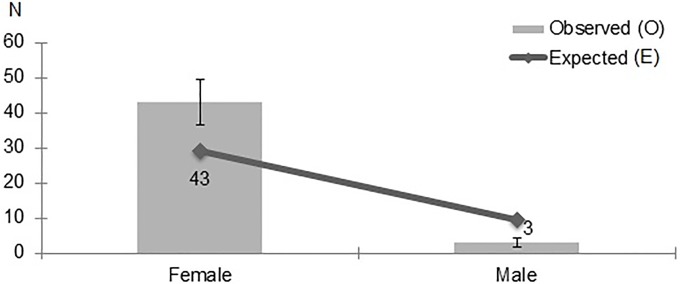
Gender distribution of JHS patients, as diagnosed with Sache’s scale.